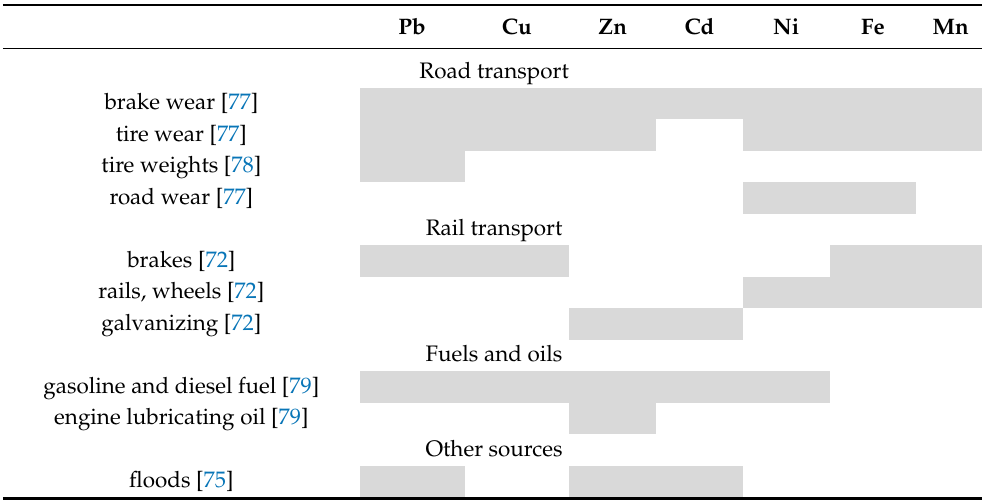
Table 5. Specific pollution sources in the area of Varaždin